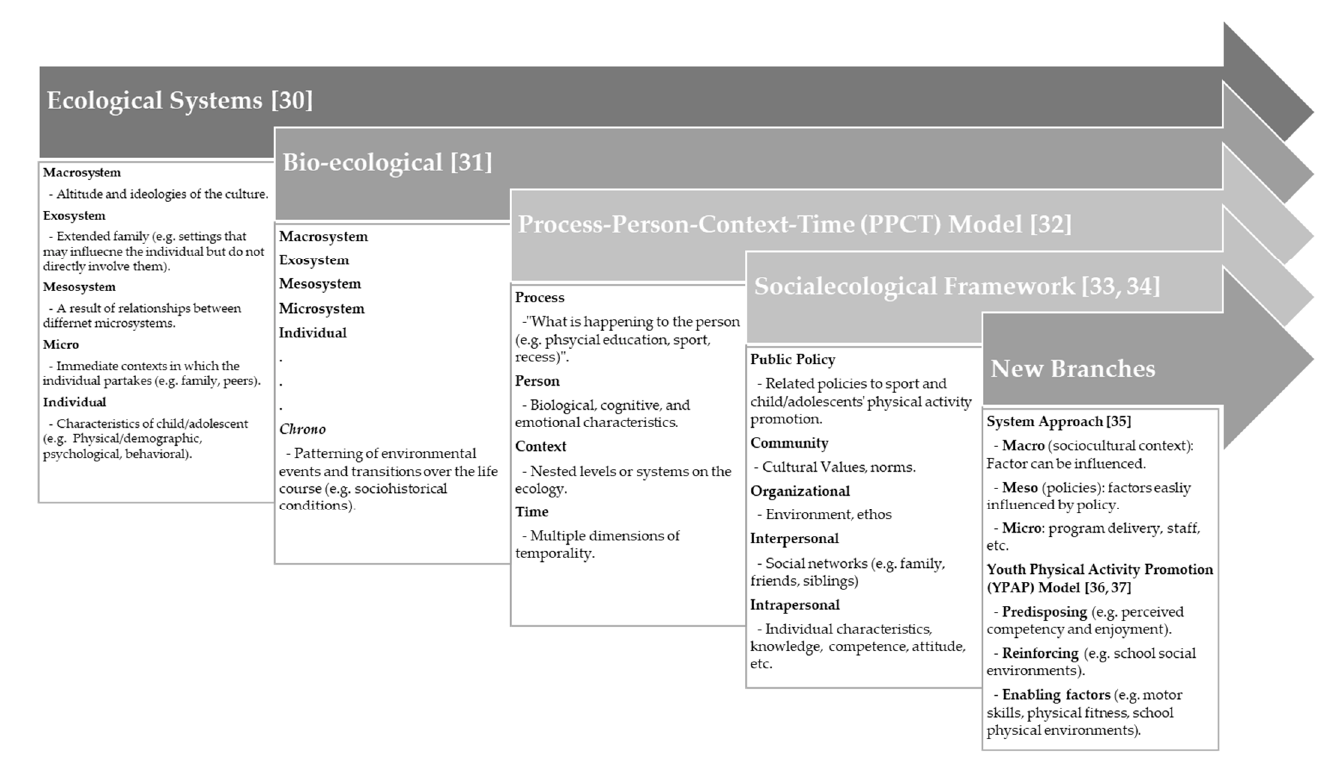
Figure 1. Diagram of the theoretical frameworks regarding child and adolescent development and physical activity participation.